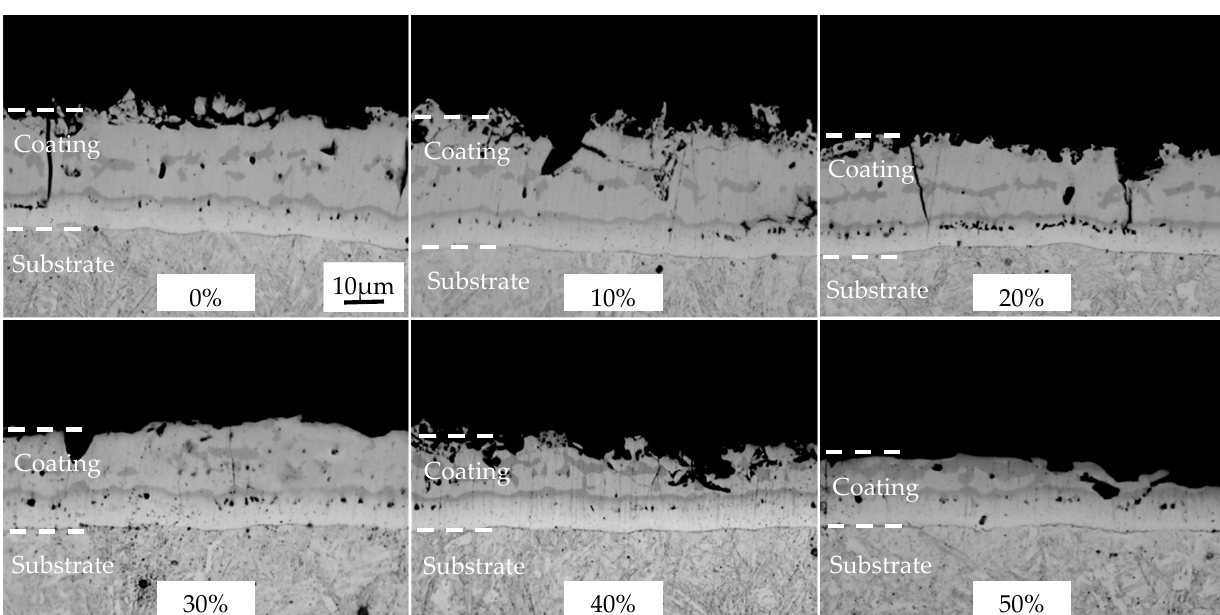
Figure 12. OM micrographs of AS60/60 coating at different reduction ratios at TAUS = 930 °C for 5 min.